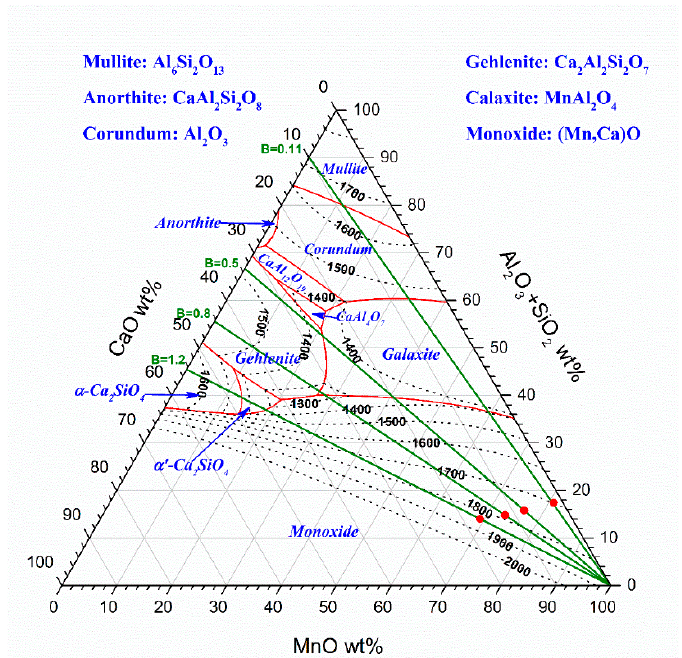
Figure 10. Calculated liquidus relations for MnO–SiO 2 –CaO–Al 2 O 3 (Al 2 O 3 / SiO 2 = 1.24) system. Green lines represent the reduction paths for Comilog charges with different basicities, red dots represent the starting points after pre-reduction.